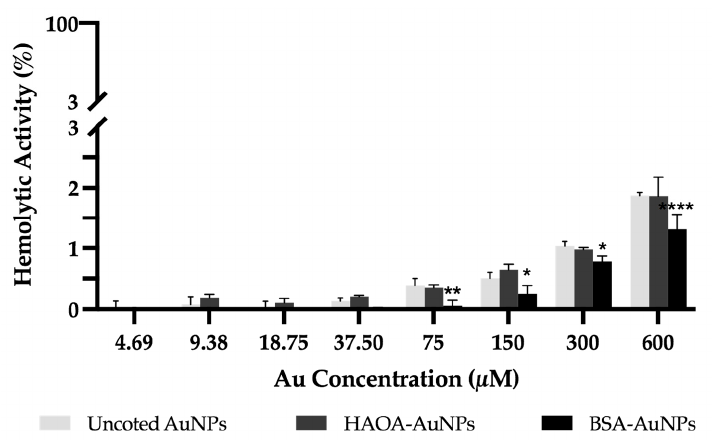
Figure 6. Hemolytic activity of uncoated AuNPs, HAOA-AuNPs and BSA-AuNPs at concentrations ranging from 600 up to 4.69 µM. Data are presented as mean value ± SD, n = 3. Two-way analysis of variance (ANOVA), Dunnett’s test ( p < 0.05), were used to detect differences between the groups. * p < 0.0332, ** p < 0.0021 and **** p < 0.0001 vs. uncoated AuNPs at same concentration.